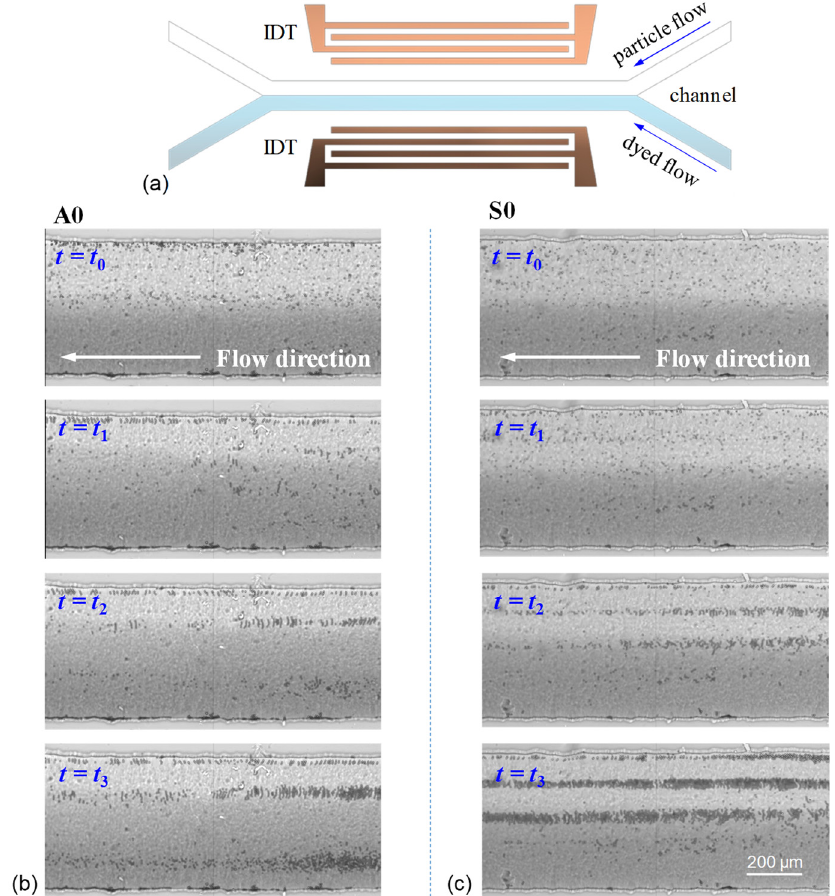
Figure 9. ( a ) Device layout and channel configuration with the main channel width w = 500 μ m for acoustic aggregation. Experimental results of particle aggregation at different time t ( t 0 < t 1 < t 2 < t 3 ) in the channel flow actuated by the standing Lamb waves of ( b ) the A0 mode and ( c ) S0 mode. The total volume flow rate is 4 μ L/min, and the used RF power is 30 dBm.